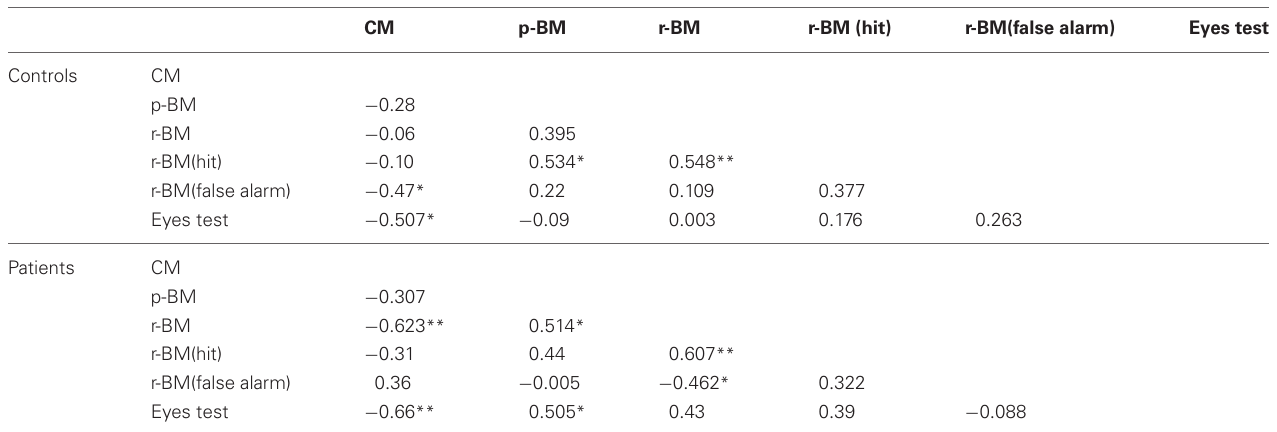
Table 4 | Correlations between the performances on the visual and cognitive tasks used in this